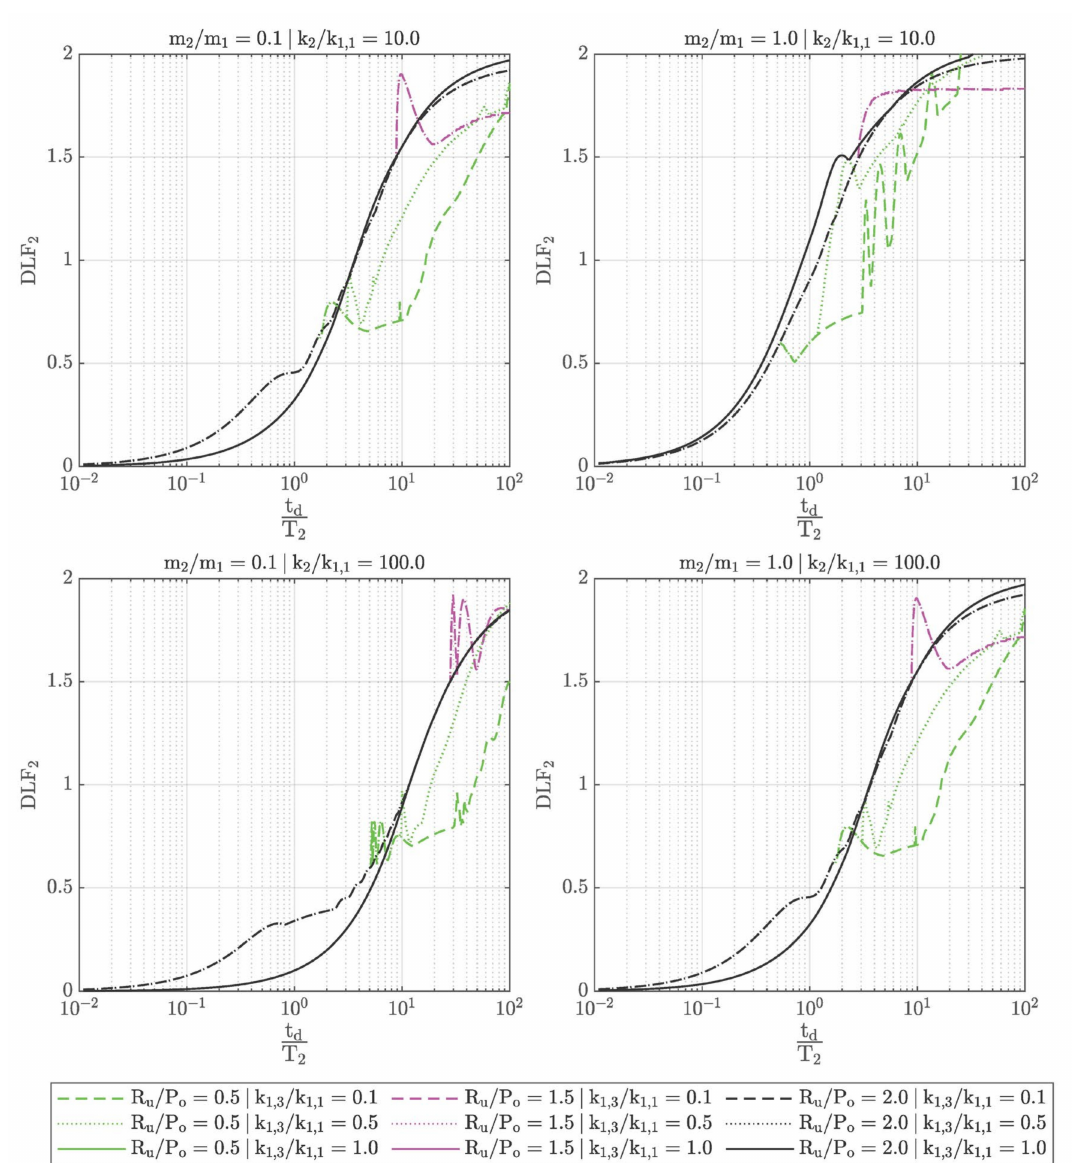
Figure 5. DLF 2 of supporting structure for typical mass, bending stiffness, and membrane stiffness arrangements ( m 2 / m 1 = 0.1, 1.0, k 2 / k 1,1 = 10.0, 100.0, and k 1,3 / k 1,1 = 0.1, 0.5, 1.0) at resistance ratios R u /P o = 0.5, 1.5,